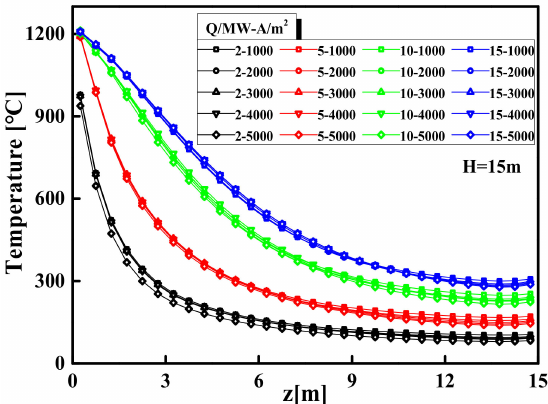
Figure 12. Comparison of plume centerline temperature in different space